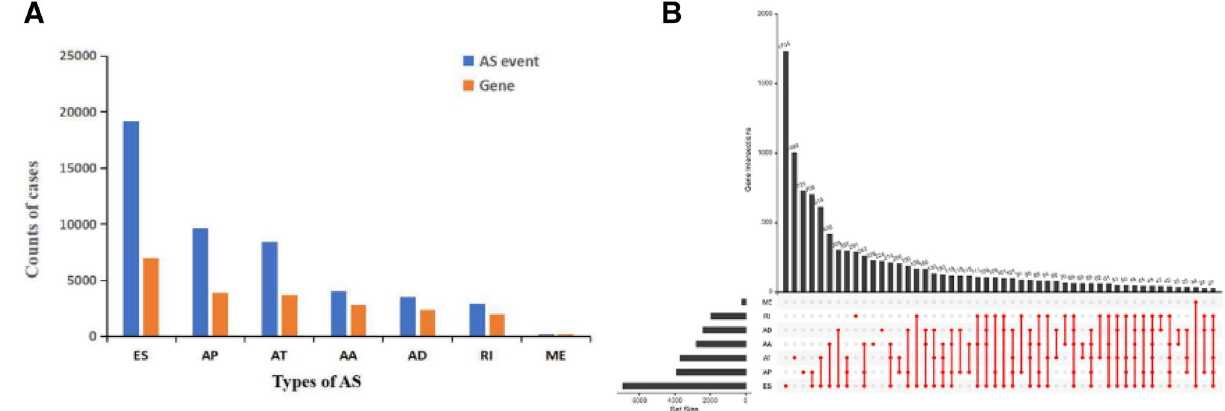
Figure 1. Summary of AS events of OC. ( A ) Counts of AS events and correlated genes. ( B ) Upset plot in OC, showing the interactions among seven types of AS events. One gene may have up to five types of AS